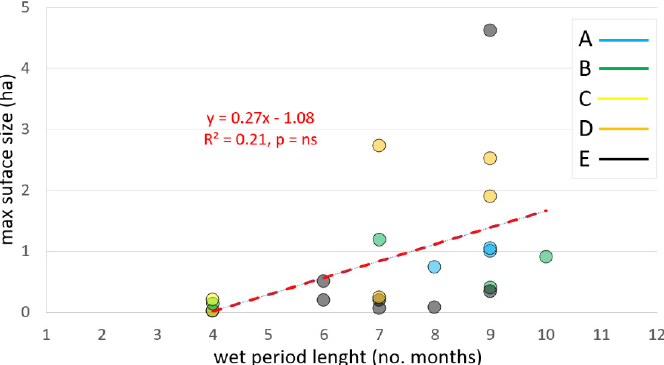
Figure 7. Correlation between the wet period length (months) and the max surface size (ha) of the 21 monitored coastal ponds. The monitored coastal ponds are grouped as indicated in Figure 1: A, pastures; B, agricultural with grasses; C, reserves; D, urban; E, mixed agricultural and pastures.